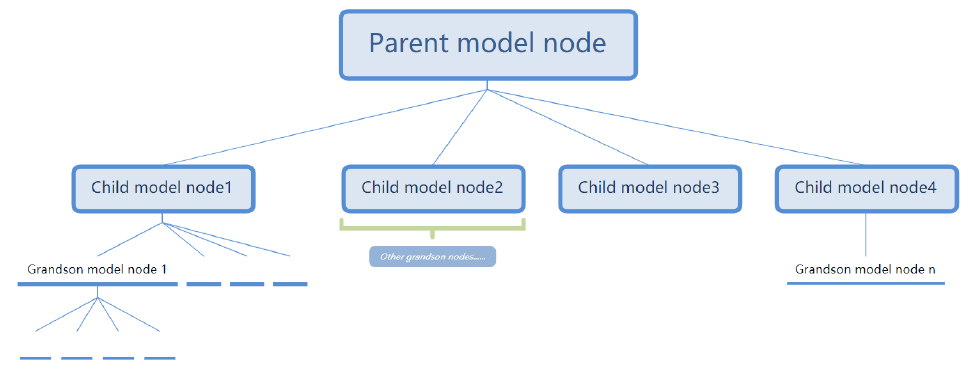
Figure 7. Tree view of 3D model disassembly.